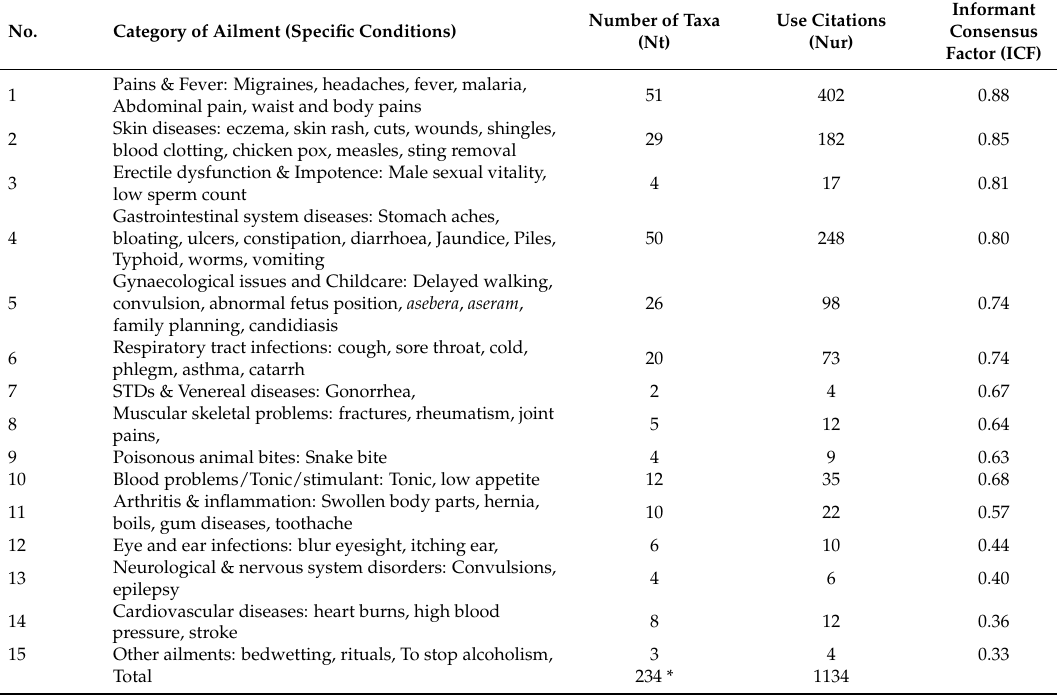
Table 4. Informant consensus factor (ICF) values for ailment categories of medicinal plants in Ejisu-Juaben